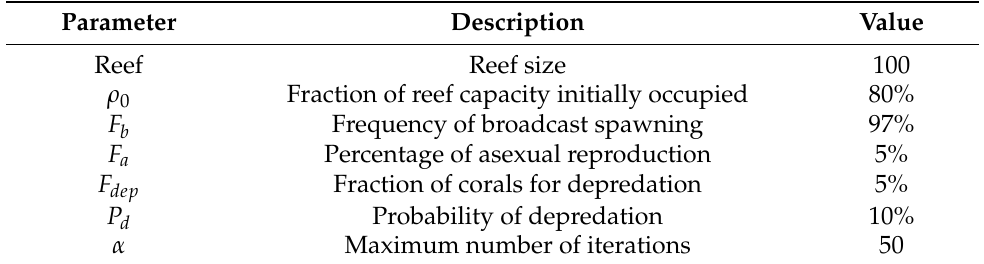
Table 1. Parameters values used the